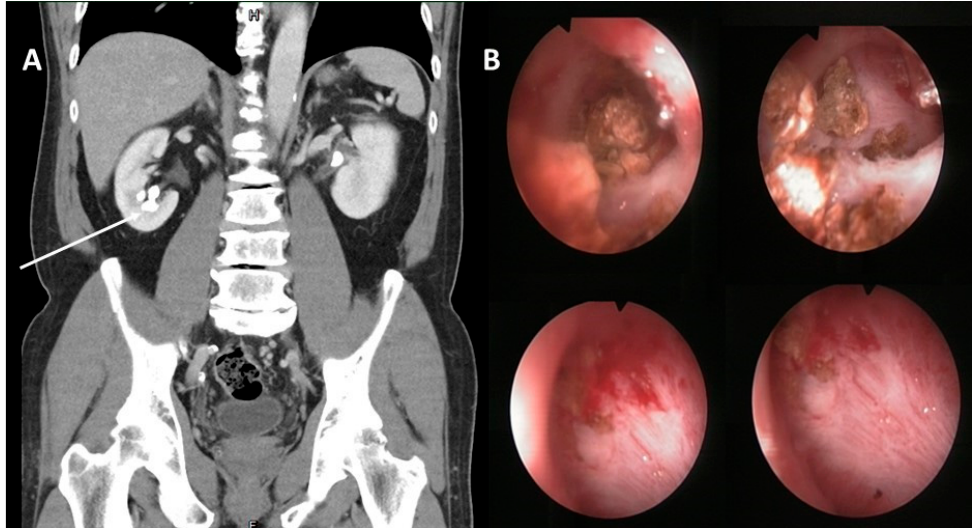
Figure 1. ( A ) Renal stones were noted over the right lower calyx and the tract of the puncture is indicated by a white arrow. ( B ) Renal stones were removed smoothly with slight blood oozing in the renal pelvis at an irrigation pressure of 100 cm H 2 O.